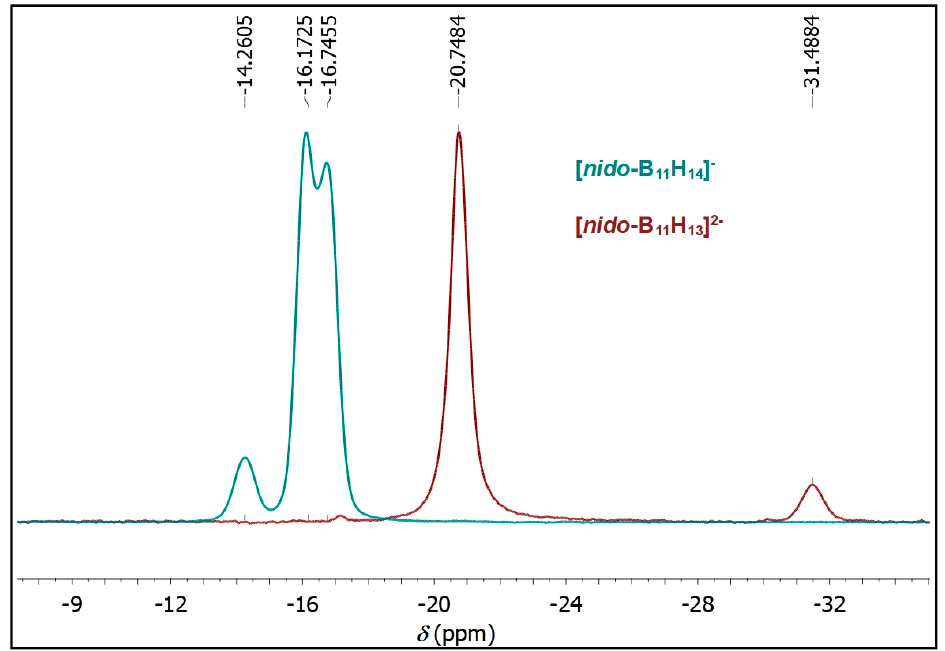
Figure 2. 11 B nuclear magnetic resonance (NMR) spectrum of [ nido -B 11 H 14 ] - and [ nido -B 11 H 13 ] 2- in CD 3 CN.